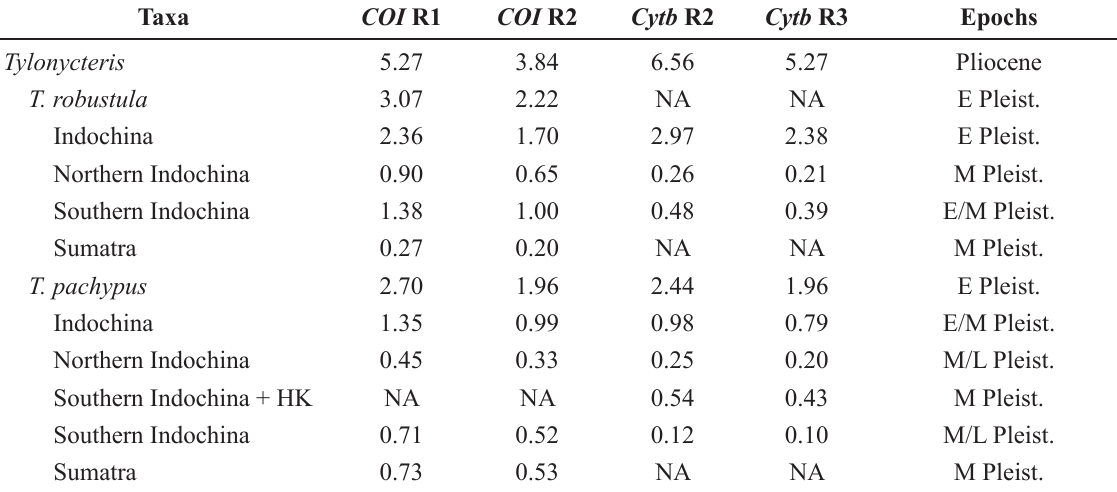
Abbreviations: HK = Hong Kong; NA = not applicable; Pleist. = Pleistocene; E = Early; M = Middle; L =